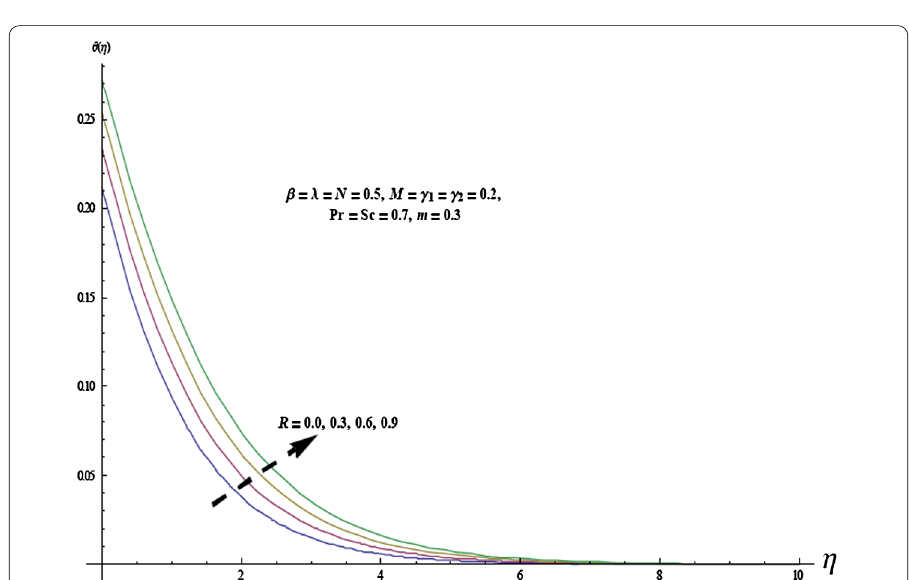
Figure 10 Variation of γ 1 on θ ( η ).